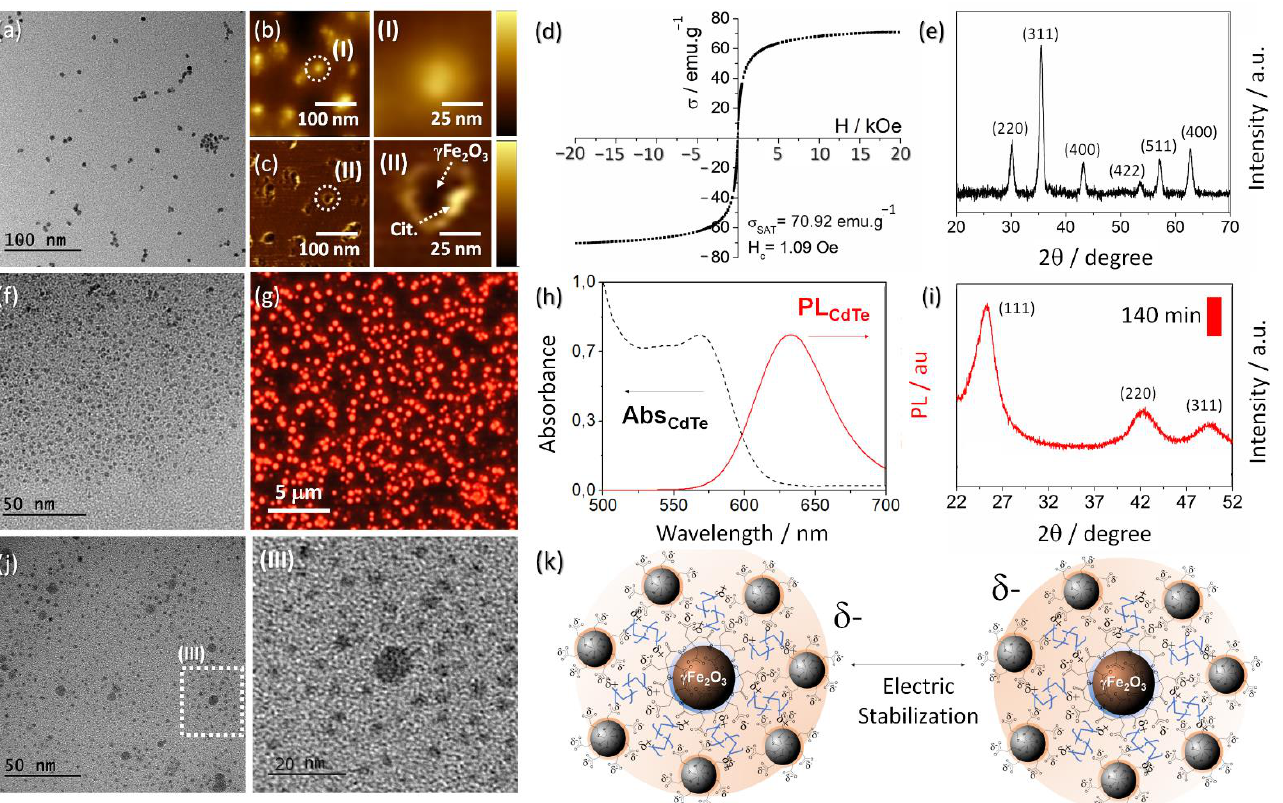
Figure 2. ( a ) TEM micrograph of MNP. ( b , c ) AFM topography and phase contrast images, respec- tively, of induced-agglomerated MNP showing the interaction among iron oxide nanoparticles and the existence of exposed citrate at the nanoparticles surface. (I, II) Inset: digital zoom-in from b and c, respectively. ( d ) Magnetization curve of MNP. ( e ) Powder diffraction of MNP with diffraction planes assigned. ( f ) TEM micrograph of QD. ( g ) Fluorescence image of aggregated QD obtained by an inverted fluorescence microscope. ( h ) Absorption and emission spectra of QD under 470 nm ex- citation. ( i ) Power diffraction of QD after 140 min reaction. ( j ) TEM micrograph of MNP@QD. (III) Inset: digital zoom-in from j. ( k ) Pictorial representation of the electric stabilization of the